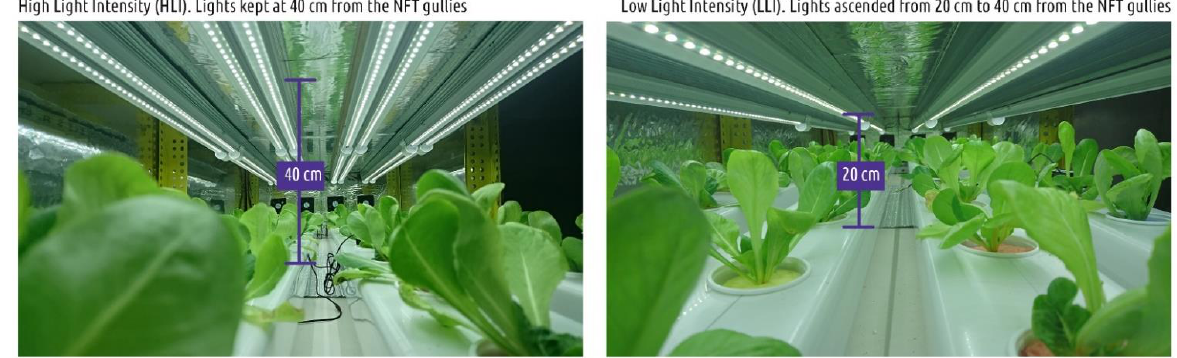
Figure A2. The photon flux density measurements were carried out using LI-188B Integrating quantum/Radiometer/Photometer, LI-COR INC, Lincoln, NE, USA. The LED tubes were attached on an aluminum base that allowed them to ascend and descend manually. The measuring tape indicated the distance between the LED tubes and the layer’s surface. The photometer was placed on a white A4 paper that was separated into 9 squares. Readings were recorded for each of those squares to completely map out the PPFD of each layer in relation to the LED tube’s distance which ranged from 10 cm to 40 cm.